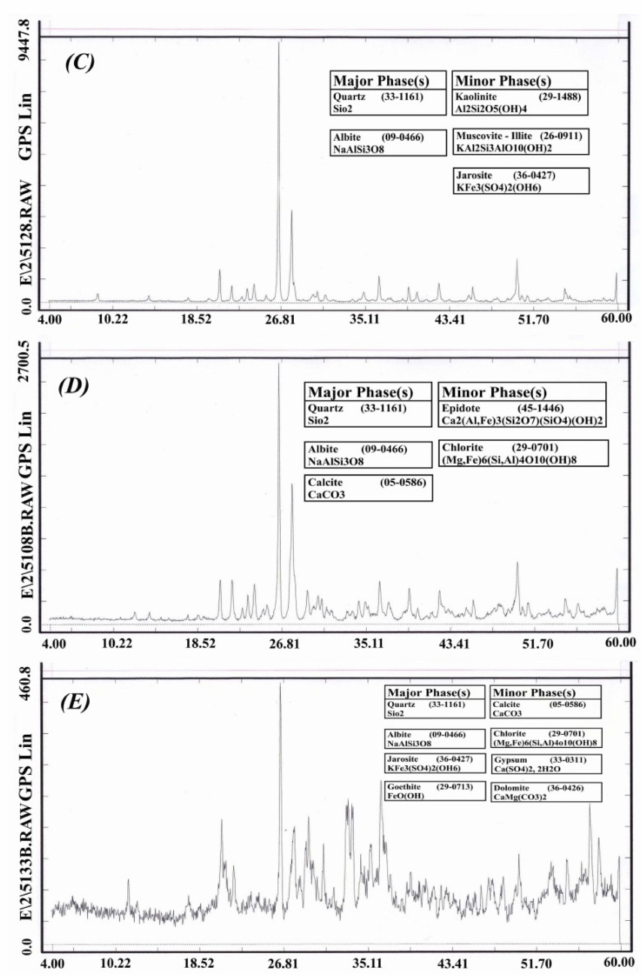
Figure 22. Representative XRD analysis of samples collected from hydrothermal alteration zones in the study area. ( A ) Iron oxide / hydroxide alteration (gossan covers); ( B ) Advanced argillic alteration; ( C ) Argillic-phyllic alteration; ( D ) Propylitic alteration; ( E ) Hydrous silica alteration (silicified